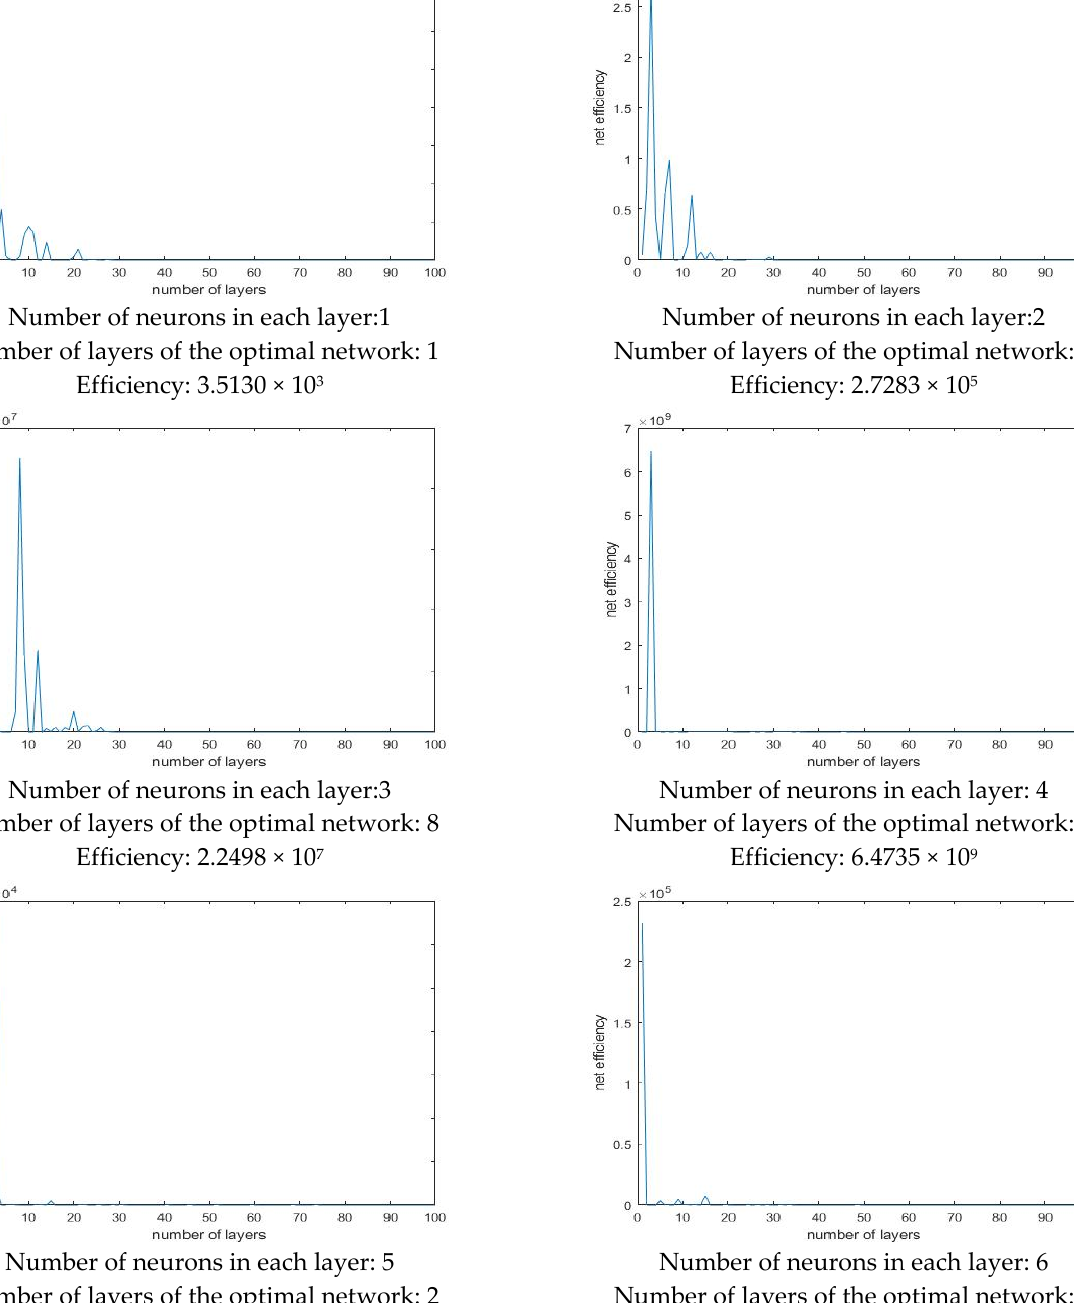
. 𝑒𝑒 = 2 𝑥𝑥 1 + 3 𝑥𝑥 2 + 1